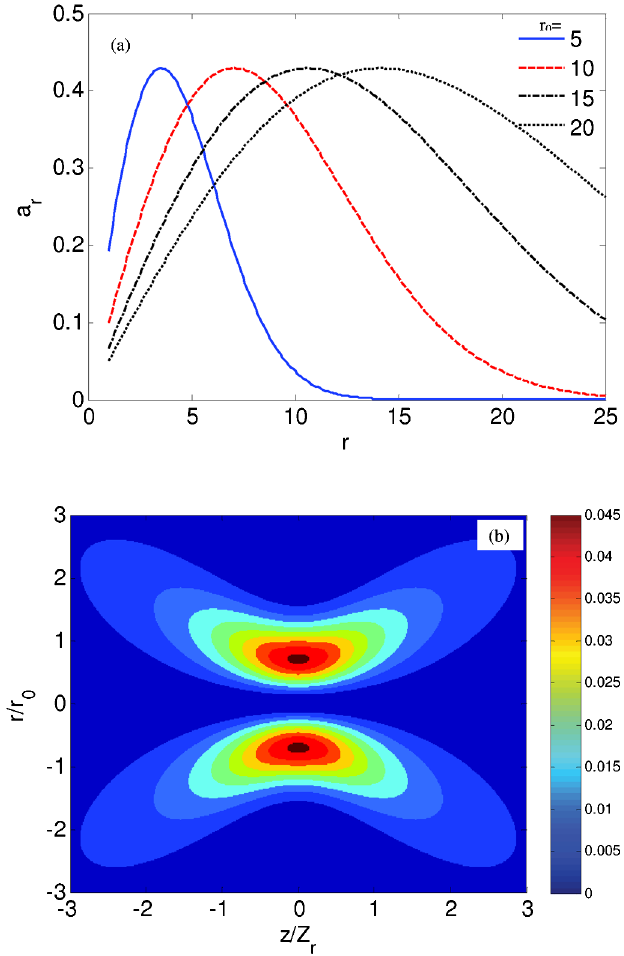
FIG. 1. (a) Normalized radial field intensity as a function of r at z ¼ 0 . (b) The spatial distribution of radial field intensity for 10 . Normalized laser intensity parameter a r 0 ¼